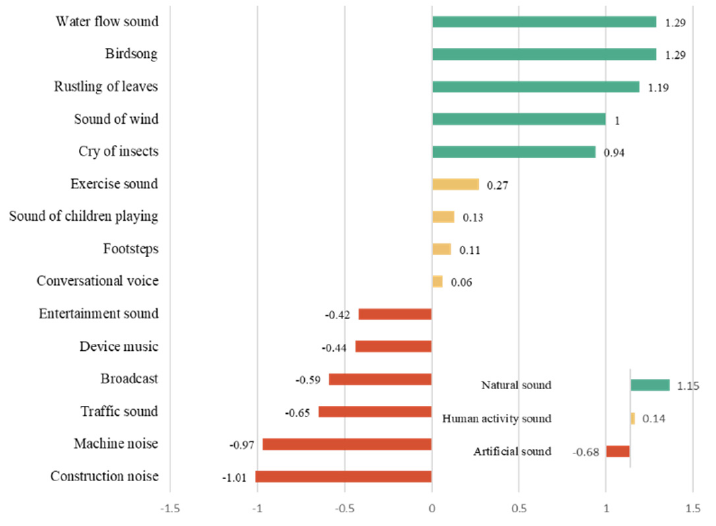
Figure 6. Average soundscape preferences of exercisers in urban forest park.